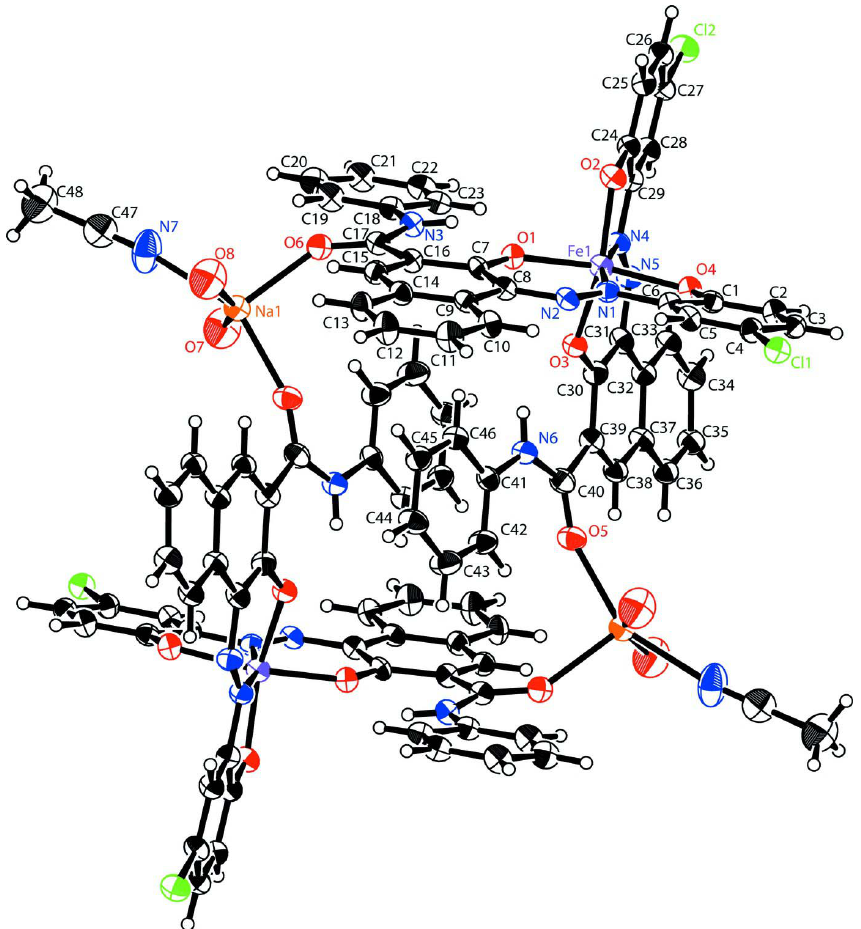
Figure 1 A view of the molecular structure of (I), showing 30% displacement